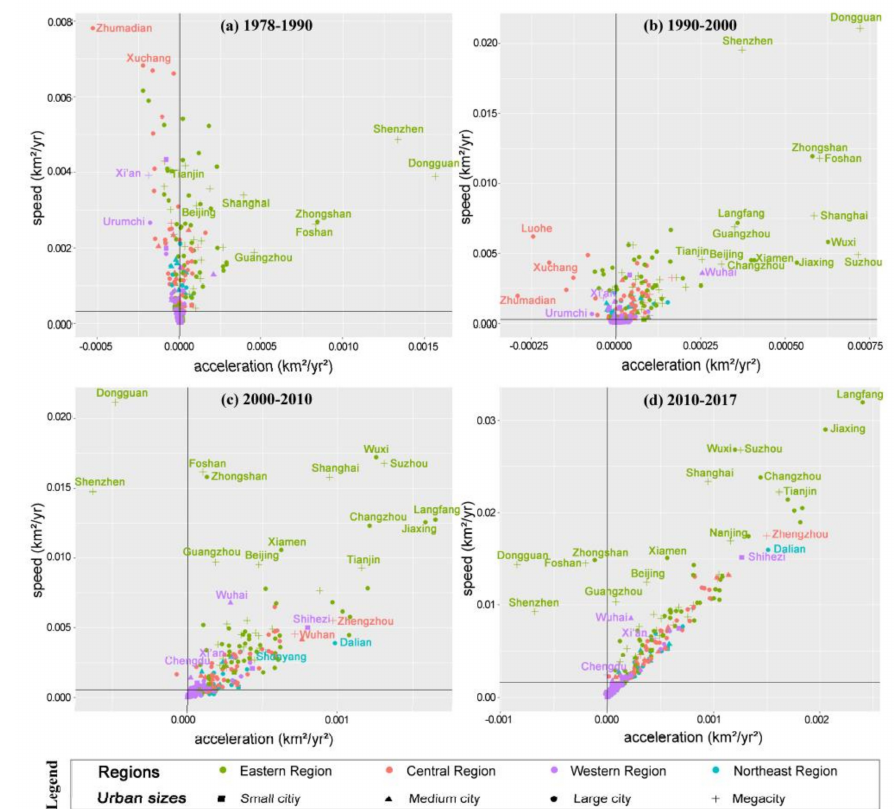
Figure 8. Categorisation results of expansion type in di ff erent periods based on speed and acceleration: ( a ) expansion type categorisation in 1978–1990; ( b ) expansion type categorisation in